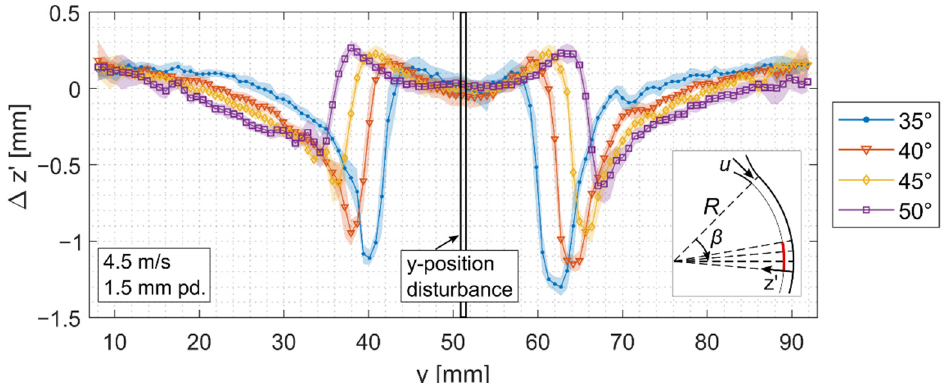
Figure 7. Relative height profile at u = 4.5 m/s for four different circumferential positions ( β ). The disturbance had a diameter of D = 1.2 mm and a penetration depth of 1.5 mm.